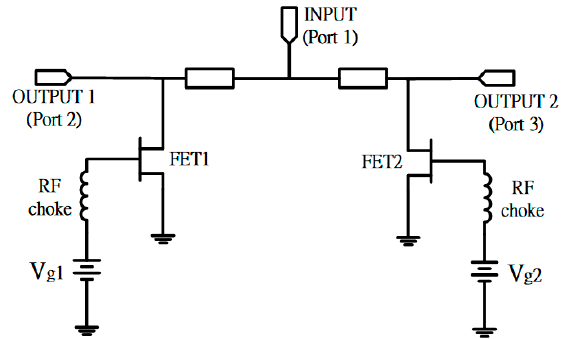
Figure 1. Schematic of the generic of a shunt-type single-pole-double-throw (SPDT) switch.